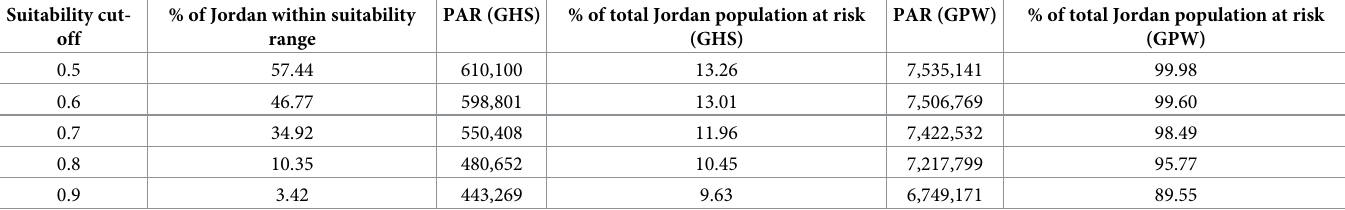
Table 10. Population at risk results. Quantification of (i) areas suitable for Phlebotomus papatasi occurrence in relation to the whole country; (ii) the population at risk of cutaneous leishmaniasis using different population grids; and (iii) the population at risk in relation to the total population, using different suitability cut-off values. Suitability cut-